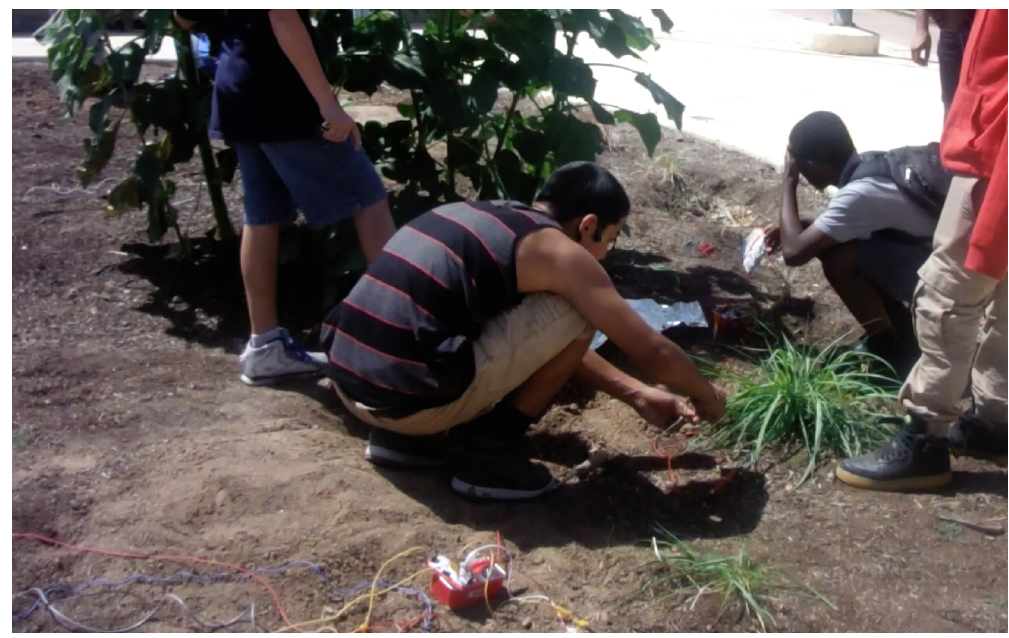
Figure 4. Children from Free Arts creating human–plant instruments using